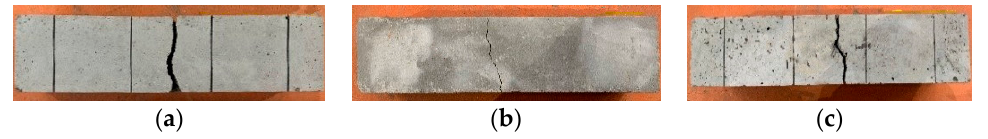
Figure 10. The flexural failure morphology of LWACs: ( a ) plain sample, ( b ) sample with BF, ( c ) sample with PANF.